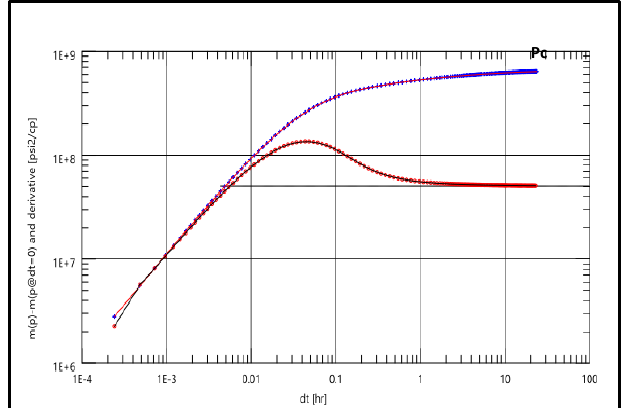
Fig. 6. Relative permeability and water saturation relationship through LET Correlation